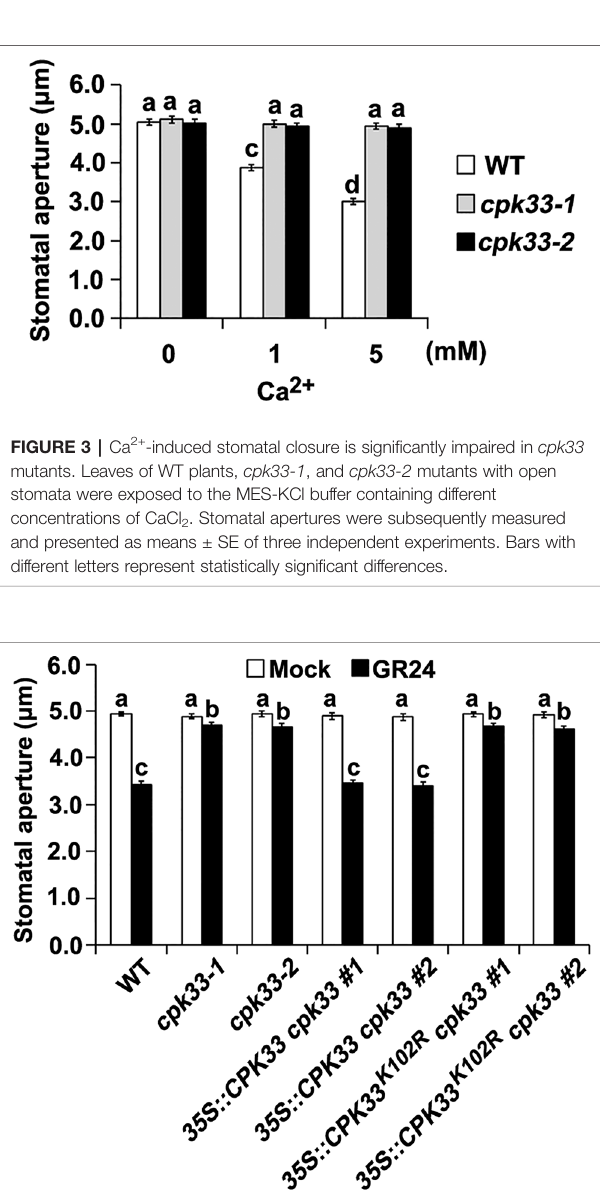
FIGURE 4 | CPK33 kinase activity is essential for strigolactone-induced stomatal closure. Leaves of WT, cpk33-1 , cpk33-2 , 35::CPK33 cpk33 #1 , 35::CPK33 cpk33 #2 , 35::CPK33 K102R cpk33 #1 , and 35::CPK33 K102R cpk33 #2 plants with open stomata were exposed to the MES-KCl buffer in the absence or presence of 1 µM GR24. Stomatal apertures were measured and presented as means ± SE of three independent experiments. Bars with different letters represent statistically signi fi cant